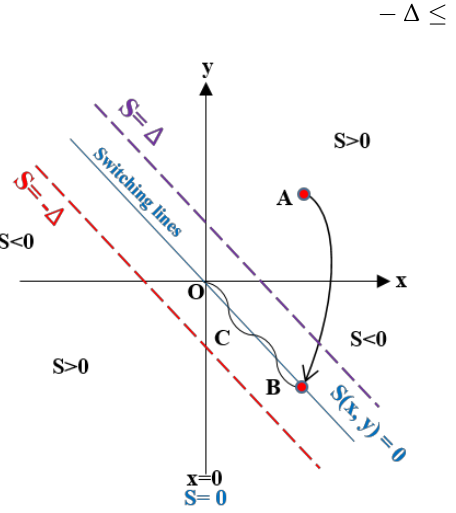
Figure 6. Regions defined by the switching logic.